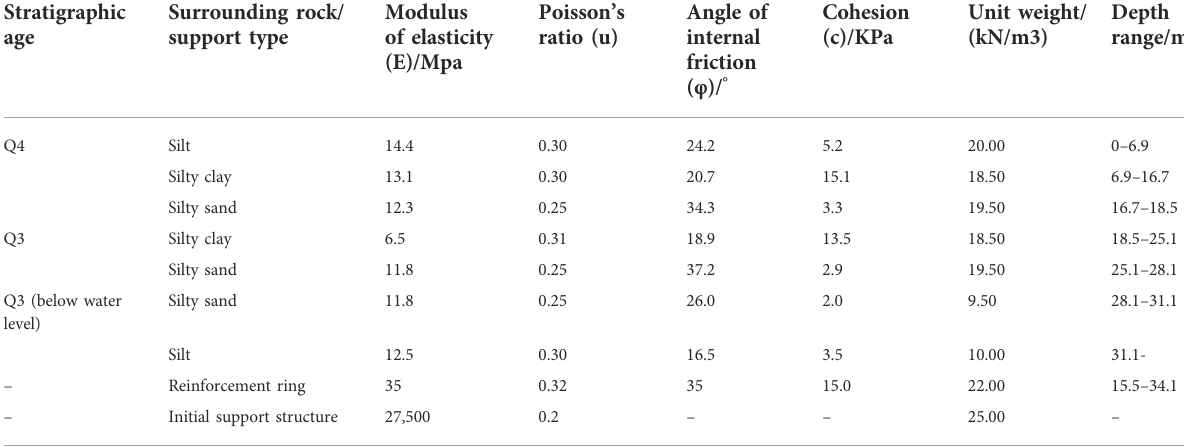
TABLE 2 Numerical simulation parameter values